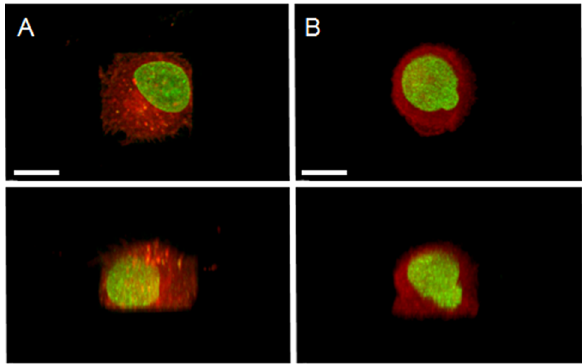
Figure 1. Control of 3D cell shape using a microwell cell culture platform. (A–B) HeLa cells (RFP-tubulin/GFP-H2B) were synchronized and cultured in square (A) or circular (B) microwells for 18 hours and imaged for nucleus (green) and cell outline (Vybrant DiD cell labeling solution, red). Images show the central xy slice of the cell (top) and the corresponding xz slice of the same cell (bottom); bars: 10 m